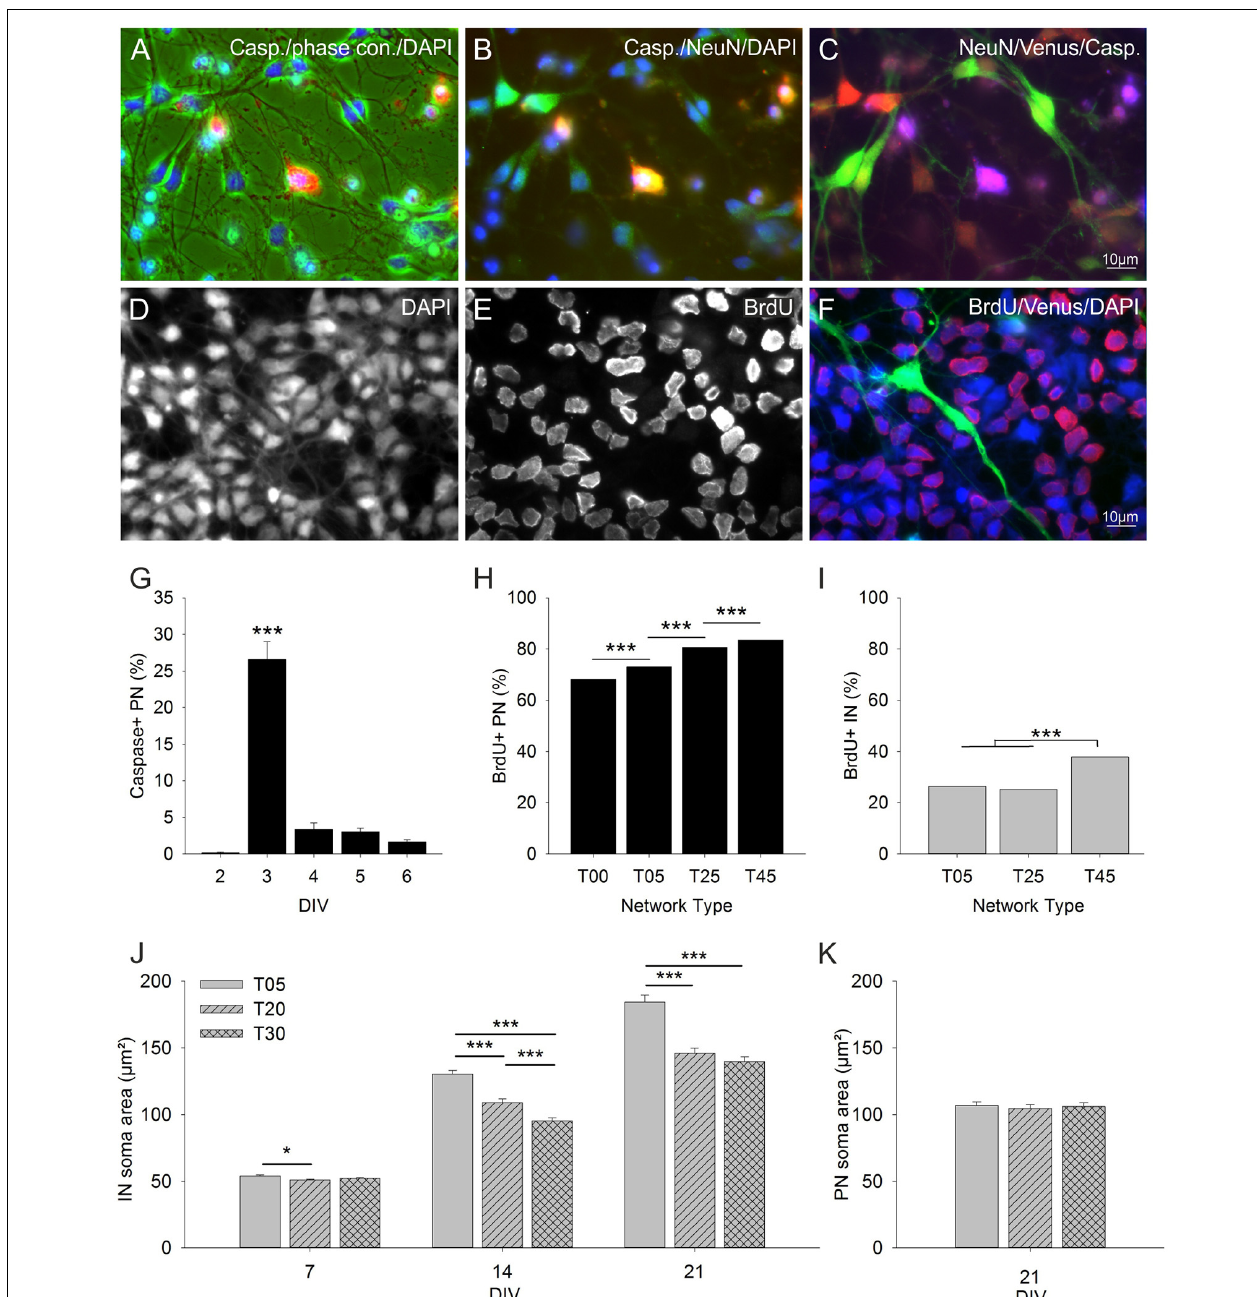
FIGURE 4 | Influence of IN density on PN cell death and cell proliferation rates. The images in (A–C) show three RGB channel combinations of the five black and white micrographs taken with different illumination from an exemplary field of an anti-Caspase stained T25 network at 3 DIV (quantitative data in graph G ). (A) caspase (red), phase contrast (green), DAPI (blue). (B) Caspase (red), NeuN (green), DAPI (blue). (C) NeuN (red), Venus (green), caspase (blue). Panels (D–F) show an exemplary field of a BrdU staining in a T25 network 24 h after BrdU application (quantitative data in graphs H and I ). (D) DAPI, (E) BrdU, (F) color combined BrdU (red), Venus (green), DAPI (blue). (G) Graph shows the fraction of anti-Caspase positive PNs in T25 networks between 2–6 DIV. The number of caspase positive PNs increased drastically 24 h after the addition of the mitotic inhibitor Ara-C at 2 DIV and dropped to low values afterward. (H) Fraction of anti-BrdU positive PNs in different network types between 2–3 DIV (standard AraC treatment was replaced by BrdU at 2 DIV and proliferation rates were assessed 12 and 24 h later; see “Materials and Methods” section). The number of proliferating PNs increased with increasing IN content. (I) Fraction of anti-BrdU positive INs. Only T45 networks showed a significant increase in IN proliferation rates. Panels (J,K) show the analysis of IN and PN soma size in T05, T20, and T30 networks. (J) IN soma size was largest in networks with the lowest IN density (T05) and decreased with increasing IN density (T20, T30). PNs soma size did not vary with IN content (K) . Asterisks show the level of statistical significance (* P ≤ 0.05, *** P ≤ 0.001). For n values see “Materials and Methods”, for statistics, see “Results” Section.